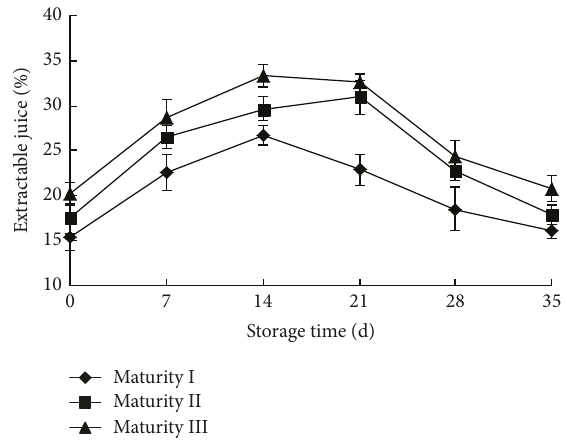
Figure 7: Effects of harvest maturity on extractable juice (%) in apricots; fruits with maturity class I (colored area < 50%), maturity class II (colored area 50–80%), and maturity class III (colored area > 80%) were categorized according to the yellow conversion rate. Vertical bars represent the standard errors of the means of triplicate